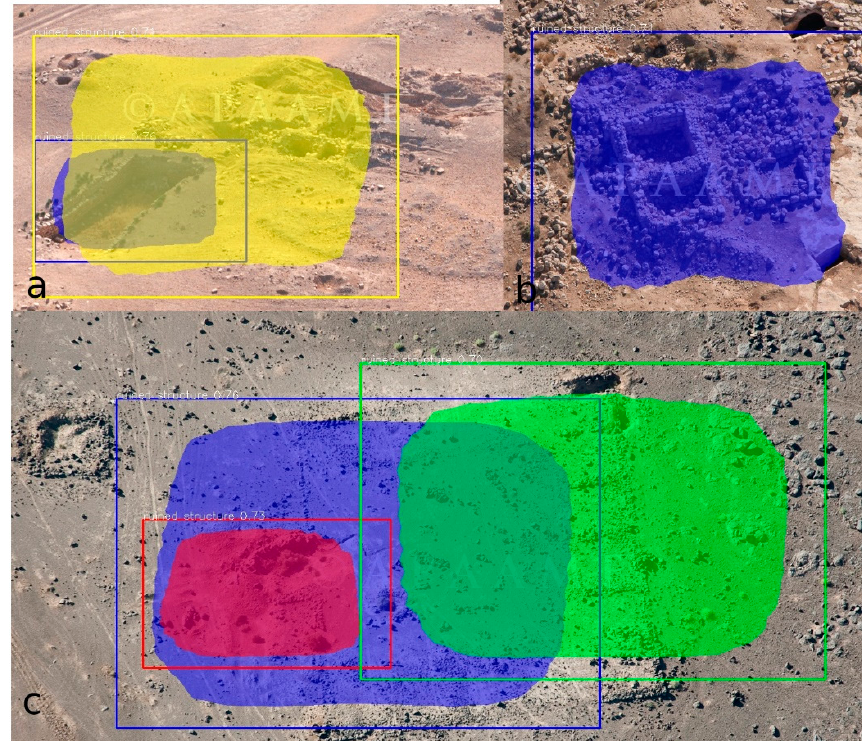
Figure 5. Segmented outputs from Figure 4 ′ s ruined structure category using the developed tool. Items (a–c) correspond to Figure 4.